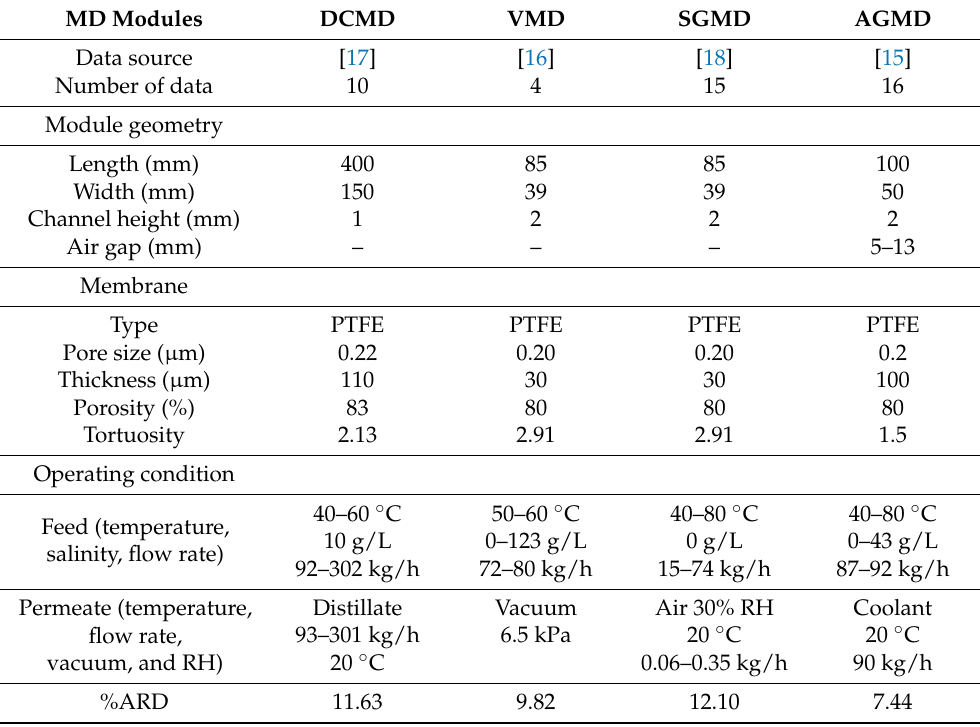
Table 5. Validation of MD modules.